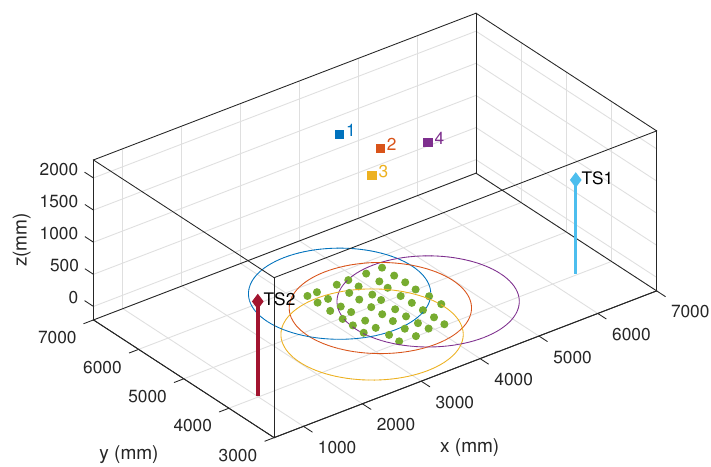
Figure 7. Positions of the emitters, receivers (green), and total stations in the test